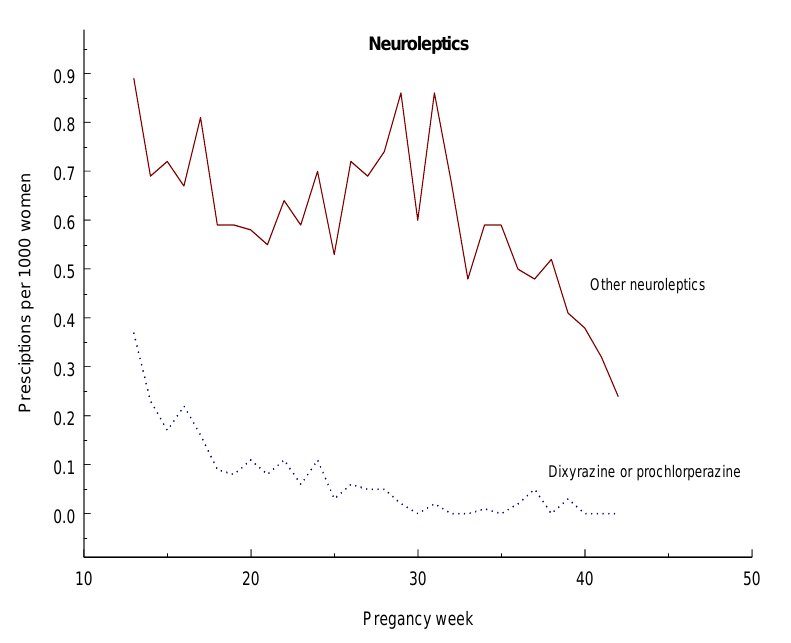
Figure 4. Diagram showing number of women per 1,000 who had filled a prescription for a neuroleptic for each gestational week during the second or third